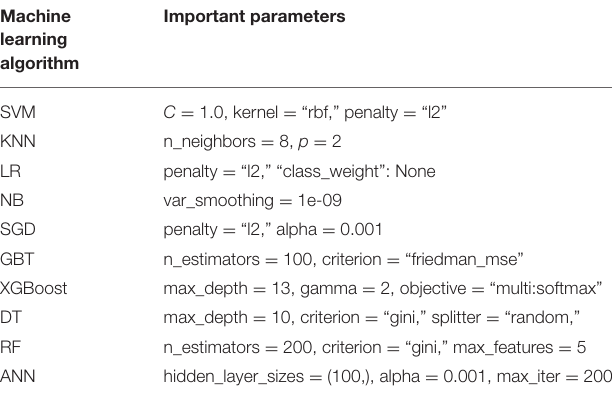
TABLE 2 | Optimal parameters. Machine